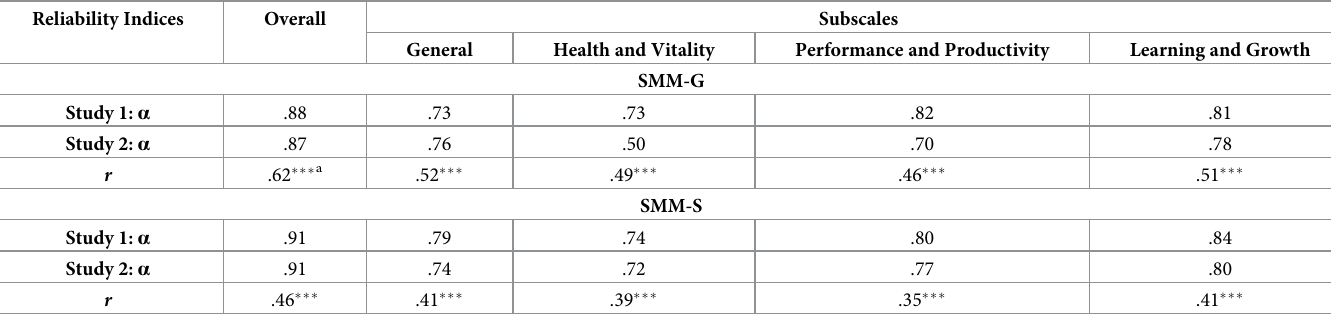
Table 6. Reliability and stability over time (10 months) of the SMM. Reliability Indices